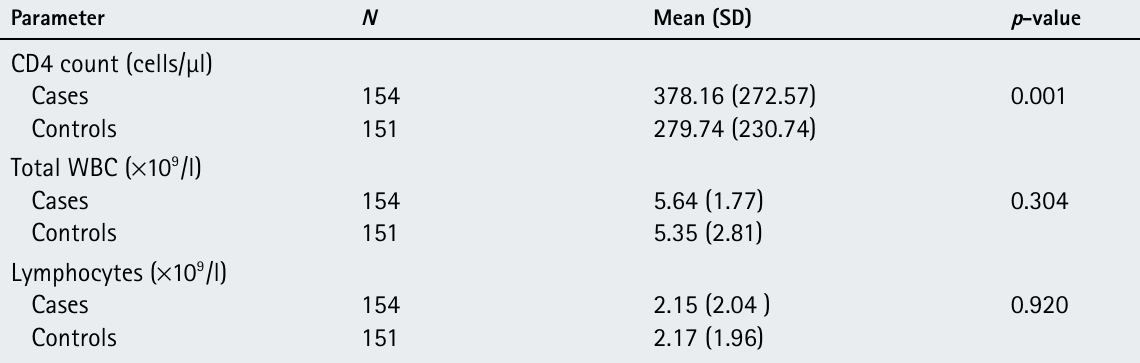
taBle iv. coMPariSon oF MeanS oF HaeMatological ParaMeterS oF caSeS v.